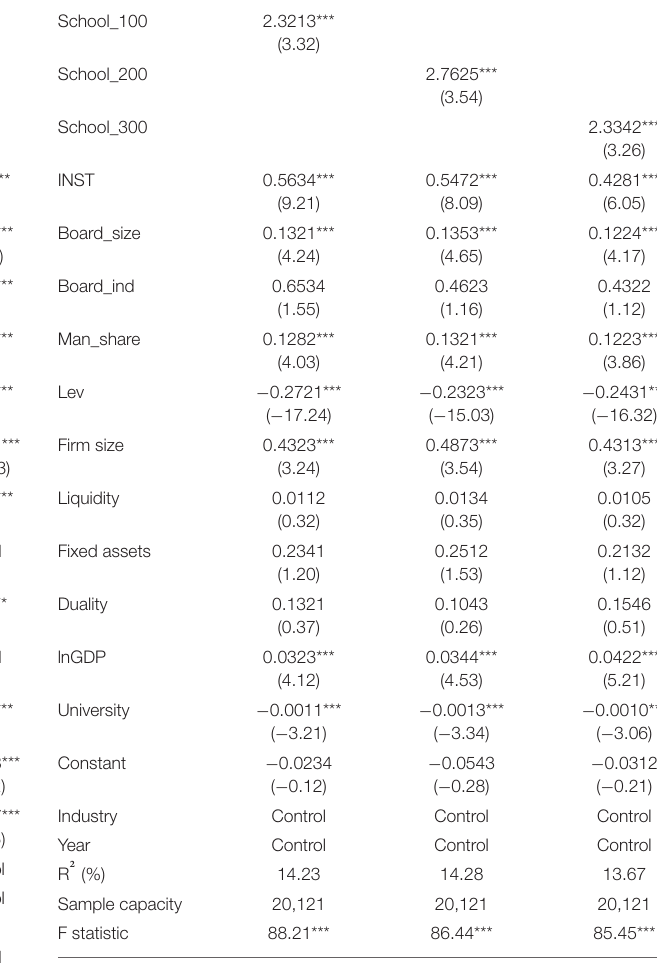
TABLE 5 | Robustness test: independent variables School_pro and CONF. TABLE 6 | Robustness test: dependent variable Tobin